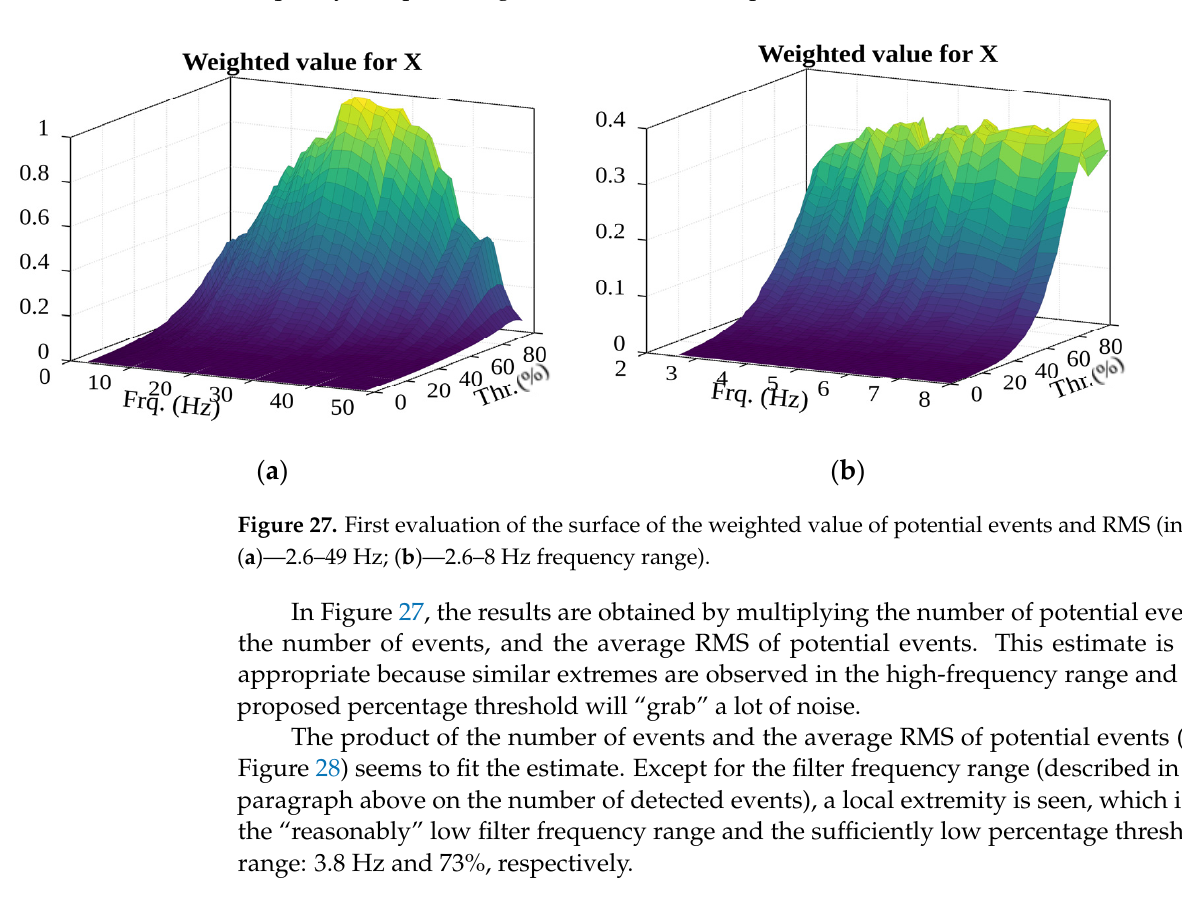
frequency range).